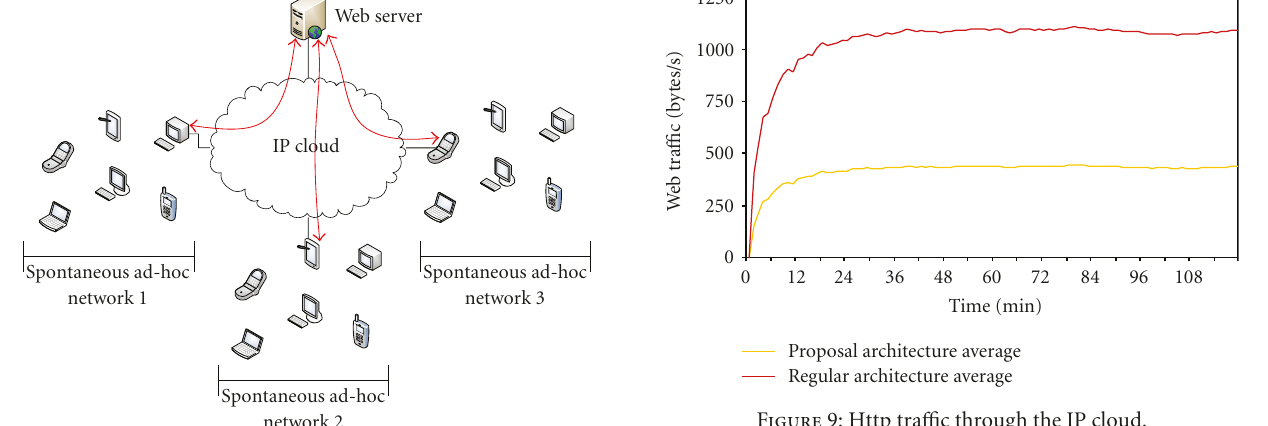
Figure 9: Http tra ffi c through the IP cloud.